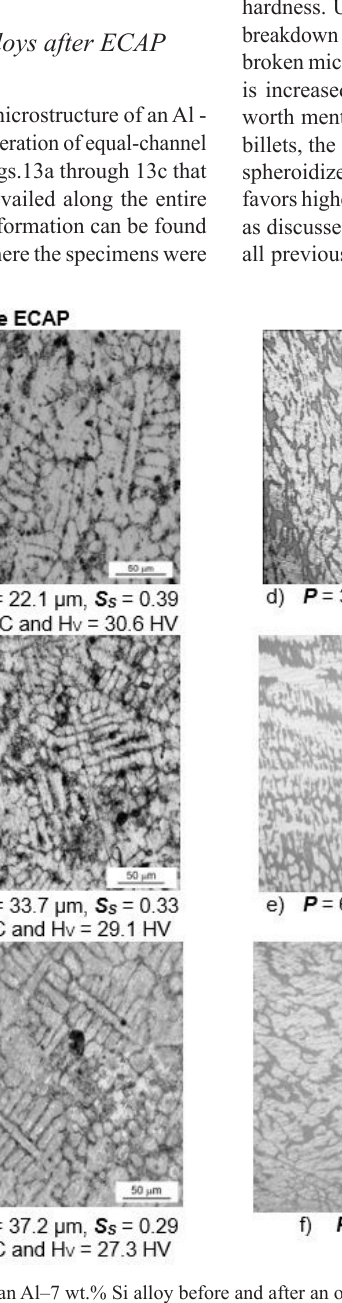
Figure 13. Dendritic microstructure of an Al–7 wt.% Si alloy before and after an operation of equal-channel angular